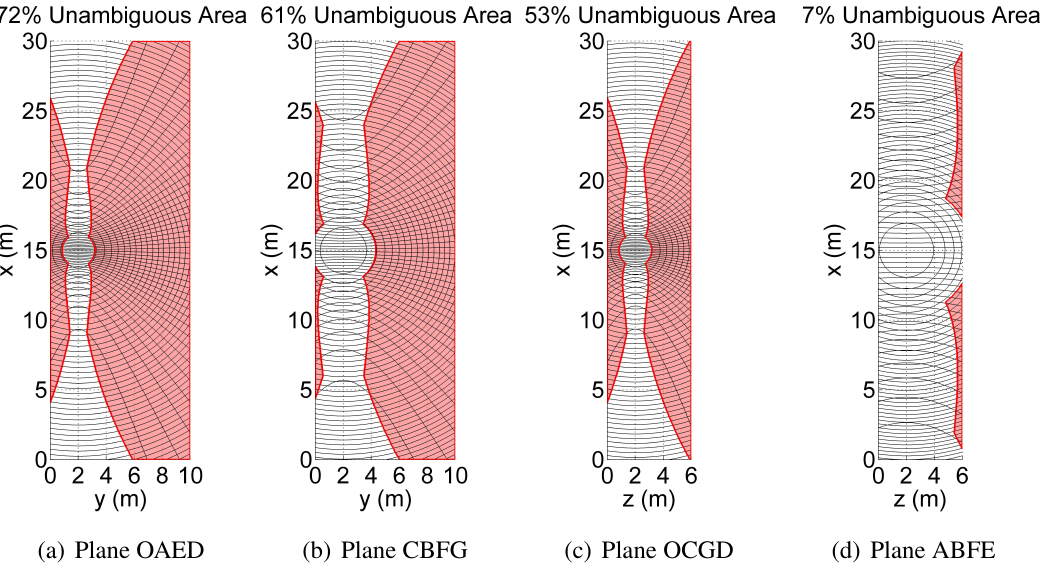
Figure 11. Total unambiguous area (in red, about 47% of the control volume surface) for the position and velocity reported in Table 7. Note that the observable walls are not depicted in the